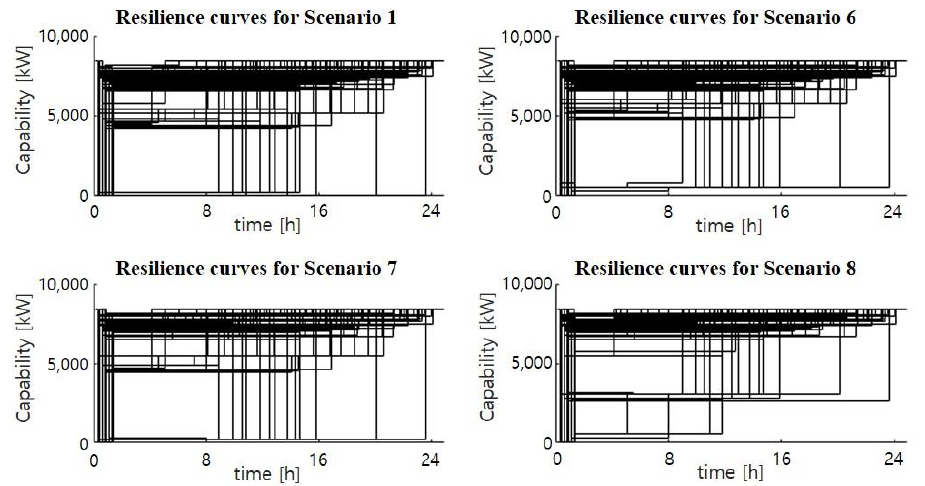
Figure A1. Resilience curves for Scenarios 1, 6, 7, and 8. Table A1. Peak load at D-university and DG capacity for Scenarios 10, 11, 15, and 16.